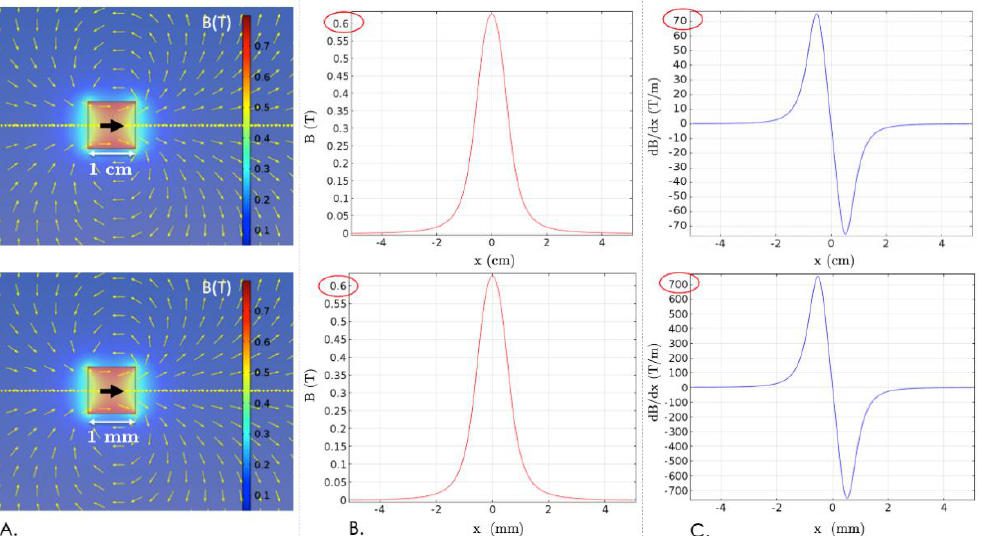
Figure 2. Illustration of scale reduction effects on the magnetic field produced by a permanent magnet. ( A ) The topology of the field around the magnet is preserved upon downscaling. ( B ) If we reduce the size of the magnet by a factor of 10, the field magnitude is identical at the same distance reduced by a factor of 10. ( C ) At the same time, the magnetic field gradient is multiplied by a factor of 10.